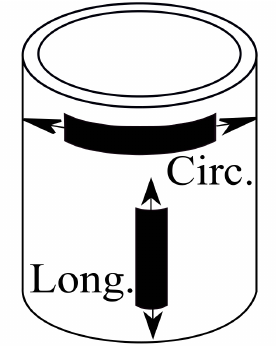
Figure 3. Graphical representation of the test tubes obtained in an